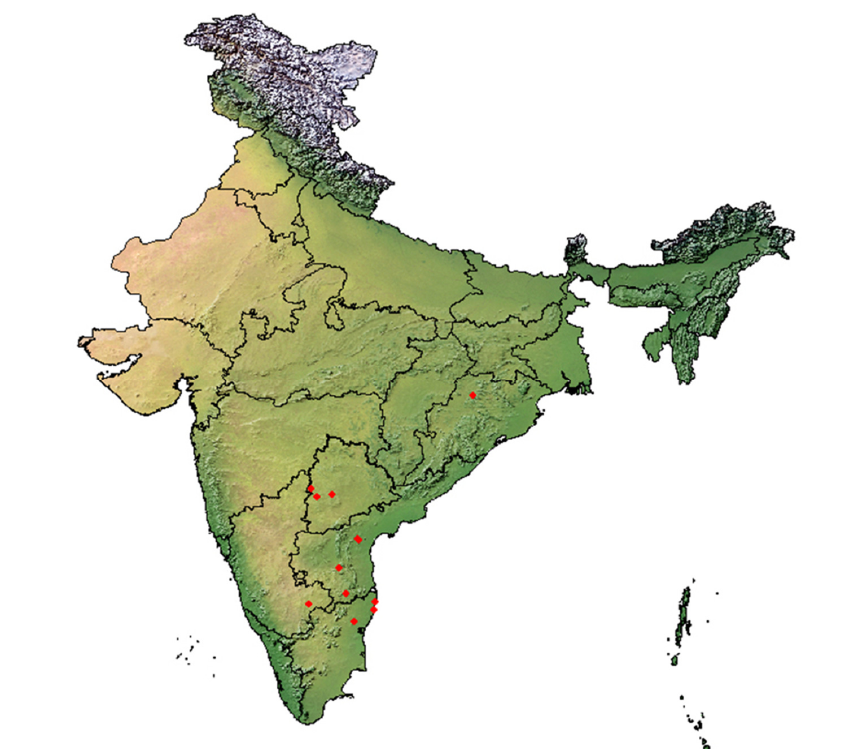
Figure 3. Distribution of Chersonesometrus madraspatensis (Pocock, 1900) in